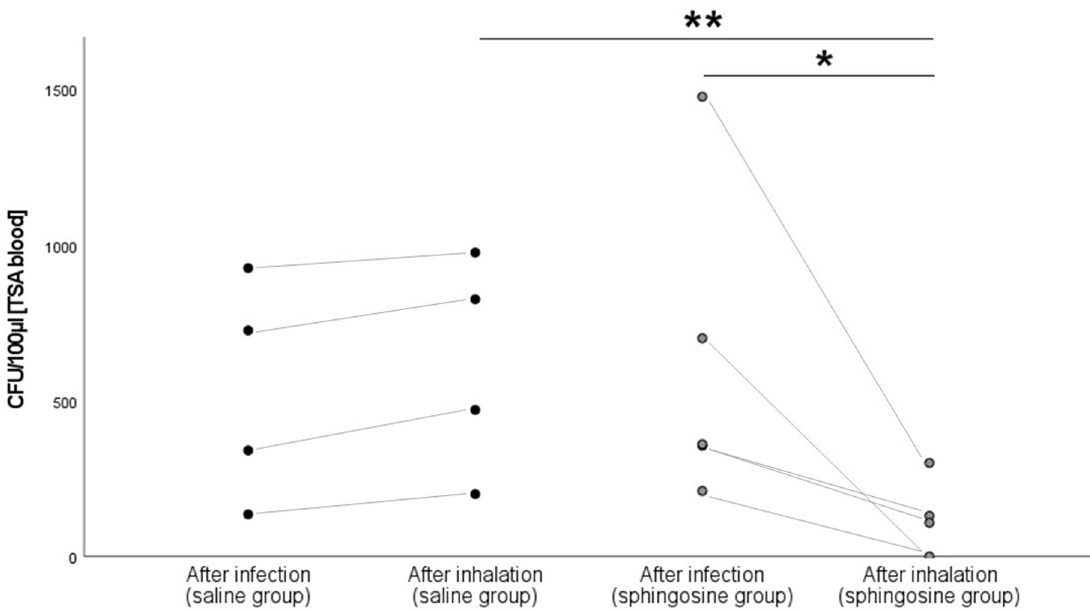
Fig 3. Analysis of CFU of streak cultures from BAL fluid (100 μ L/plate). Pigs were infected with 2 × 10 9 CFU of P . aeruginosa (ATCC 27853), BAL was performed with 10 mL (NaCl 0.9%), 5 mL were aspirated, collected and 0.1 mL aliquots were plated on tryptic soy agar plates with 5% sheep blood (Groups: “After infection”). CFU were counted after an incubation period of 18 h at 37˚C. Sphingosine inhalation (500 μ M in 5 mL 0.9% NaCl) significantly reduced CFU of P . aeruginosa , while inhalation of 0.9% NaCl was without effect (Groups: “After inhalation”). Given are dot-plots with connecting lines, n = 4 for the 0.9% control group and n = 5 for the sphingosine group: � p < 0.05, �� p < 0.01; students t-test/